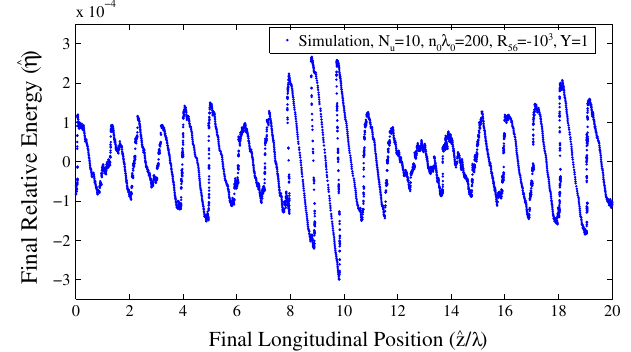
FIG. 12. Phase space of the particles following both the inter- action and dispersive regions. The example is for the undulator case with uniform initial energy (cid:2) (cid:1) ¼ 0 .